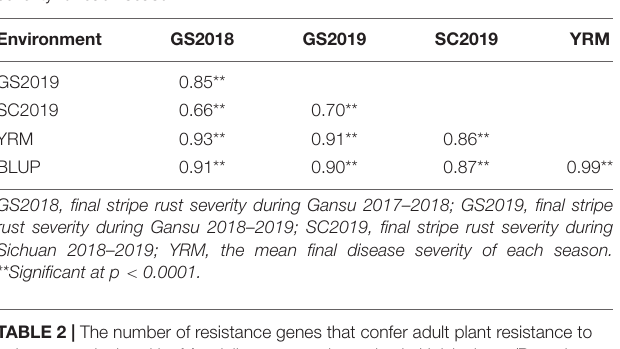
TABLE 1 | Phenotypic Pearson’s correlations for stripe rust (GS2018, GS2019, SC2019) in the Huixianhong/Pascal F 5 RIL population using the final disease severity for each season.